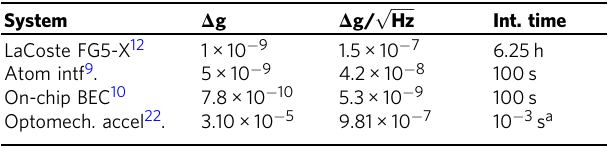
Table 1 Comparison between gravimetry sensitivities obtained by various experimental systems